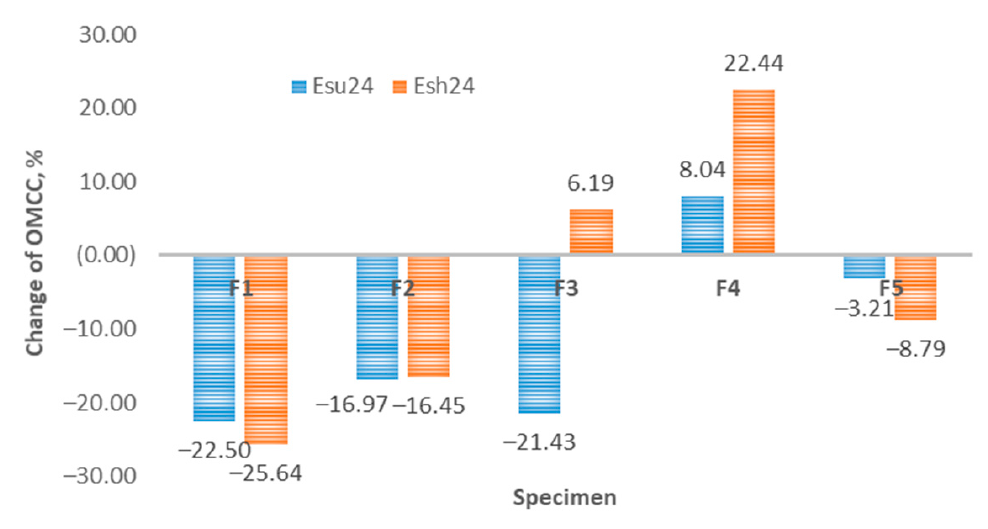
Figure 13. Change of OMMC due to aging.